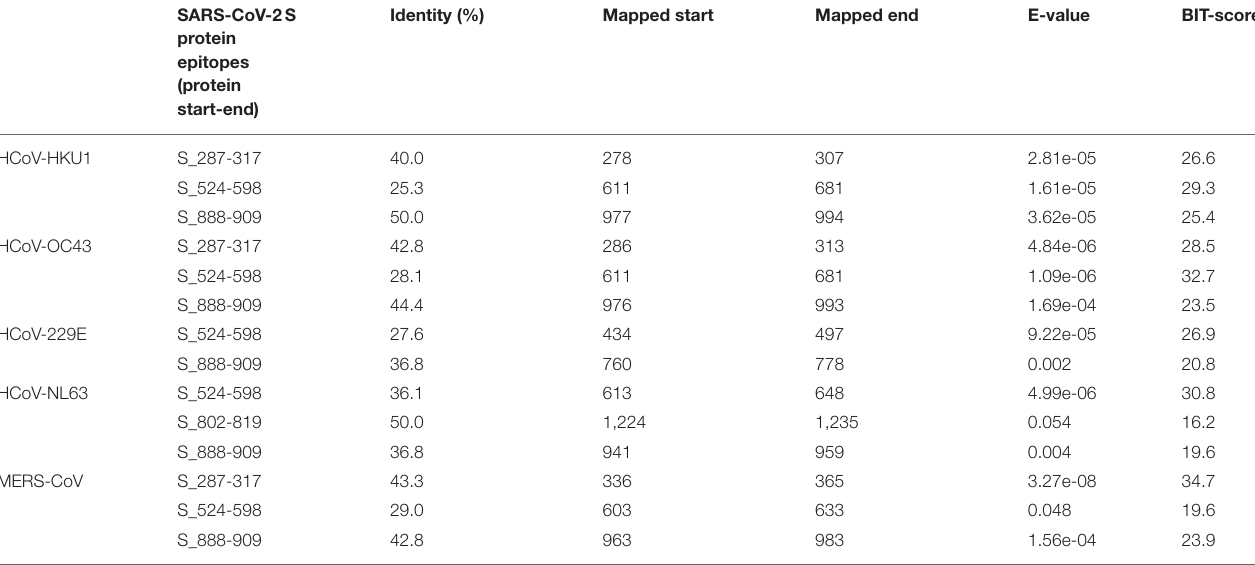
TABLE 6 | Sequence identity of S protein of human alpha- and beta-coronaviruses against SARS-CoV-2-derived B-cell epitopes (evaluated by blastp). SARS-CoV-2S protein